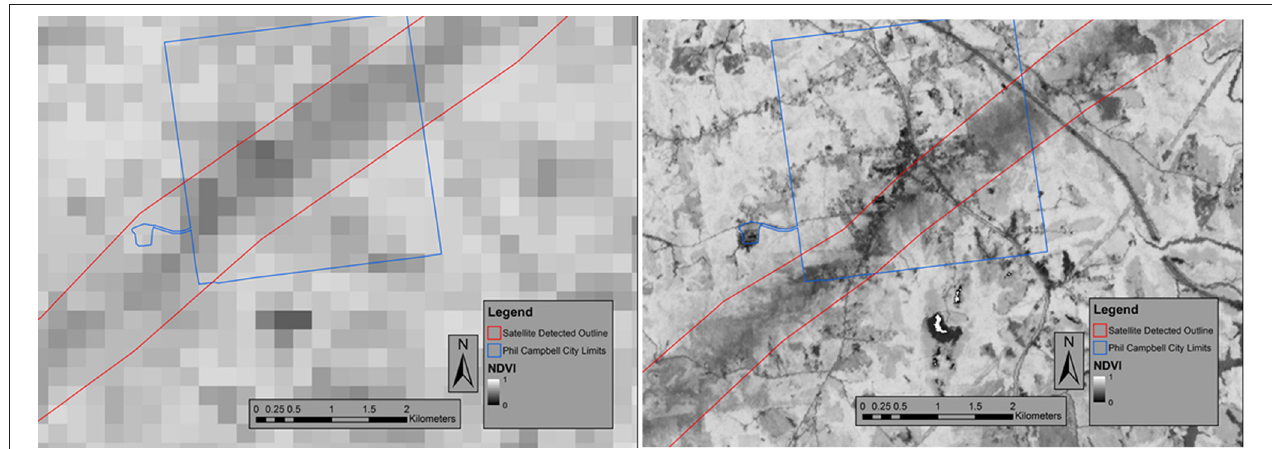
FIGURE 4 | Tornado track of April 27, 2011 near Phil Campbell, AL, is visible in NDVI imagery from Terra MODIS (250m, May 4, 2011) and Terra ASTER (15m, May 20, 2011). Image Credit: Andrew Molthan, NASA SPoRT (public